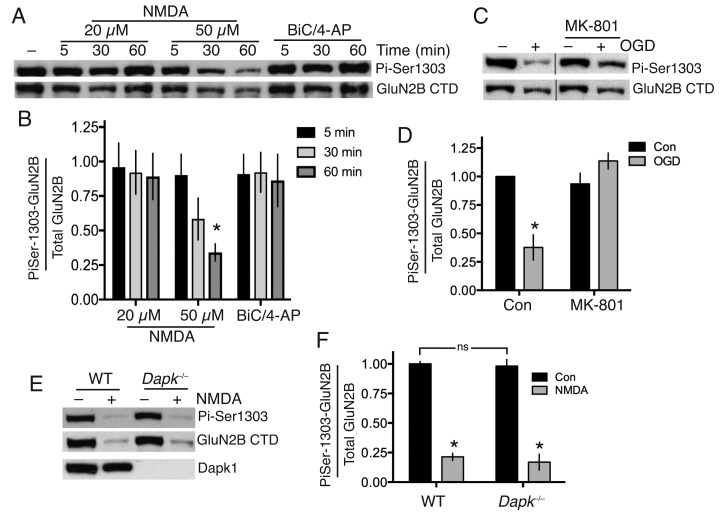
Neither Dapk1 nor excitotoxic insults increase GluN2B phosphorylation on Ser-1303.(A,B) Strong excitotoxic insults induce GluN2B Ser-1303 dephosphorylation at later timepoints. Western analysis of extracts from cortical neurons treated as indicated with NMDA or bicuculline (50 µM) plus 4-amino pyridine (250 µM). (F(2,24)=3.904, p=0.034 (Two-way ANOVA). *p=0.0053 (Sidak's post-hoc test; 95% CI of diff: 0.1777 to 1.139, comparison to control without NMDA treatment, N = 3). (C,D) Mimicking ischemic conditions triggers dephosphorylation of GluN2B Ser-1303 in an NMDAR-dependent manner. Oxygen-glucose deprivation (OGD) applied for 120 min ±MK-801 (10 µM). F(1,12)=6.69, p=0.024 (Two-way ANOVA). *p=0.0003 (Sidak's post-hoc test, 95% CI of diff: 0.3289 to 0.9172, N = 4). (E,F) Dapk1 deficiency does not influence basal or NMDA-induced GluN2B Ser-1303 phosphorylation status. Neurons were treated ±50 µM NMDA for 60 min. F(1,10)=345.1, p<0.0001 (Two-way ANOVA, Con vs. NM). *p<0.0001 (both, compared to Con of that genotype, 95% CI of diff: 0.6384 to 0.9342, and 0.6411 to 0.9826 (reading left to right), N = 4 WT, N = 3 KO; with ‘N’ defined as a distinct culture from a distinct animal). ns: F(1,10)=0.5418, p=0.4786.DOI:
http://dx.doi.org/10.7554/eLife.17161.00210.7554/eLife.17161.003Figure 1—source data 1.Data relating to Figure 1—figure supplement 1a.DOI:
http://dx.doi.org/10.7554/eLife.17161.00310.7554/eLife.17161.004Figure 1—source data 2.Data relating to Figure 1b.DOI:
http://dx.doi.org/10.7554/eLife.17161.00410.7554/eLife.17161.005Figure 1—source data 3.Data relating to Figure 1—figure supplement 1f.DOI:
http://dx.doi.org/10.7554/eLife.17161.00510.7554/eLife.17161.006Figure 1—source data 4.Data relating to Figure 1—figure supplement 1h.DOI:
http://dx.doi.org/10.7554/eLife.17161.00610.7554/eLife.17161.007Figure 1—source data 5.Data relating to Figure 1d.DOI:
http://dx.doi.org/10.7554/eLife.17161.00710.7554/eLife.17161.008Figure 1—source data 6.Data relating to Figure 1f.